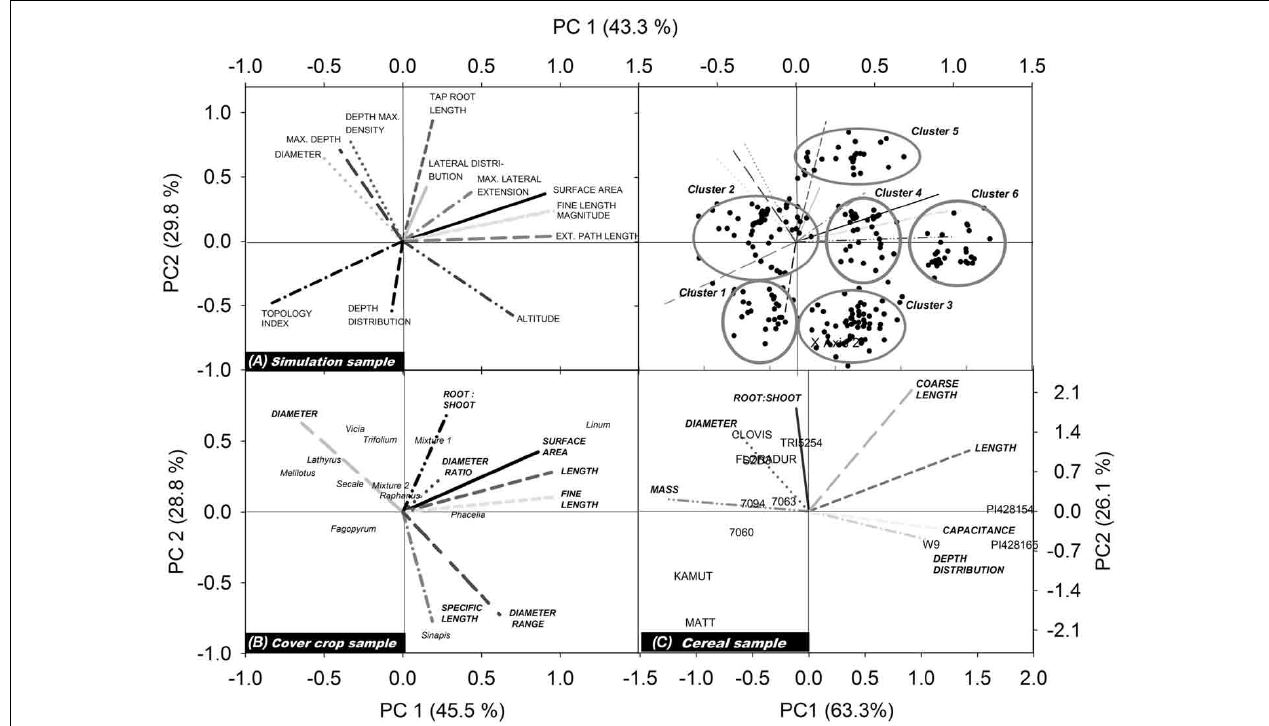
FIGURE 3 | Biplots showing trait vectors and location of the single objects from (A) the simulation sample, (B) the cover crop species sample, and (C) the cereal genotype sample. For